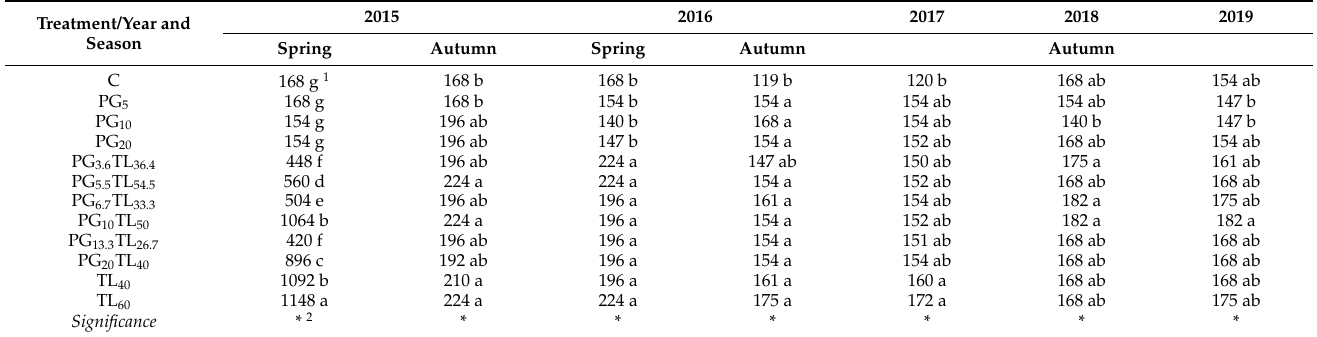
Table 12. Effect of treatments and years on the content of alkaline hydrolysable nitrogen (AH-N, mg kg –1 ) at 0–20 cm soil layer.